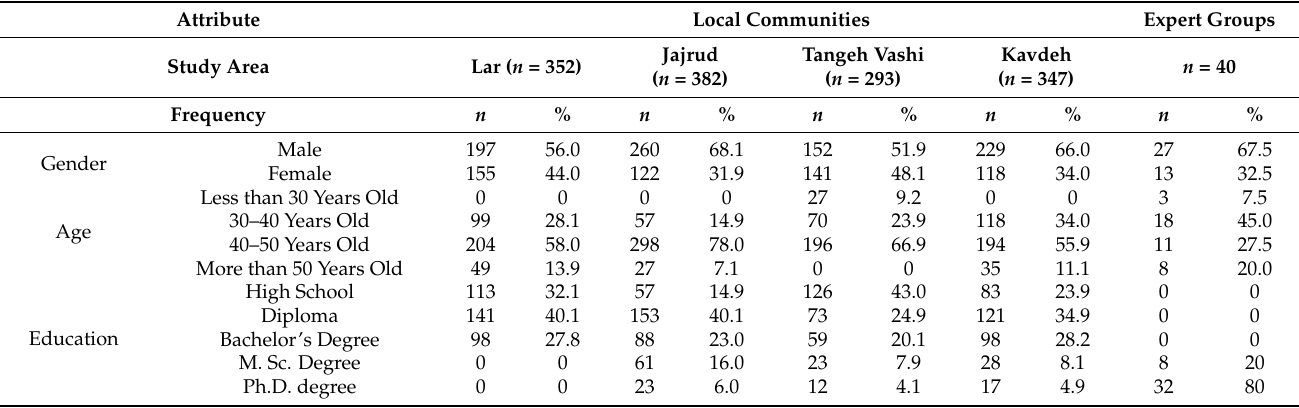
Table 5. Descriptive profile of survey